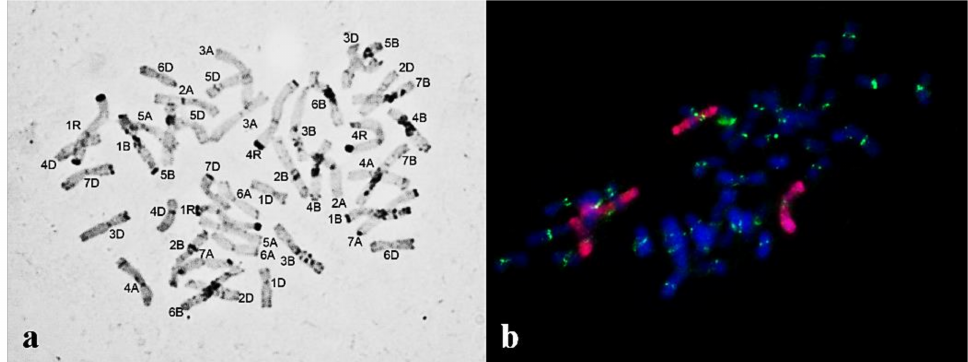
Figure 5. Chromosome sets of plants of subgroup 1a: ( a ) 2 n = 44, 1R(1A) substitution, 4R4R added (C-banding); ( b ) 2 n = 44, four rye chromosomes (GISH; rye chromosomes are labeled red and centromeres,